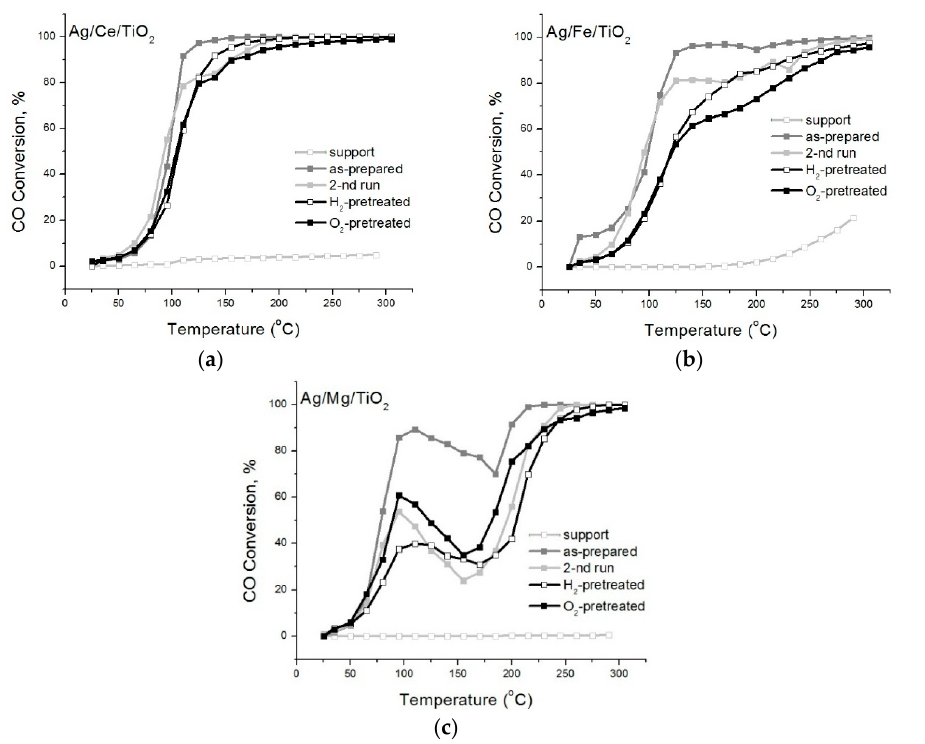
Figure 1. CO conversion vs. temperature on Ag catalysts on TiO 2 support modified with Ce ( a ), Fe ( b ) or Mg ( c ).